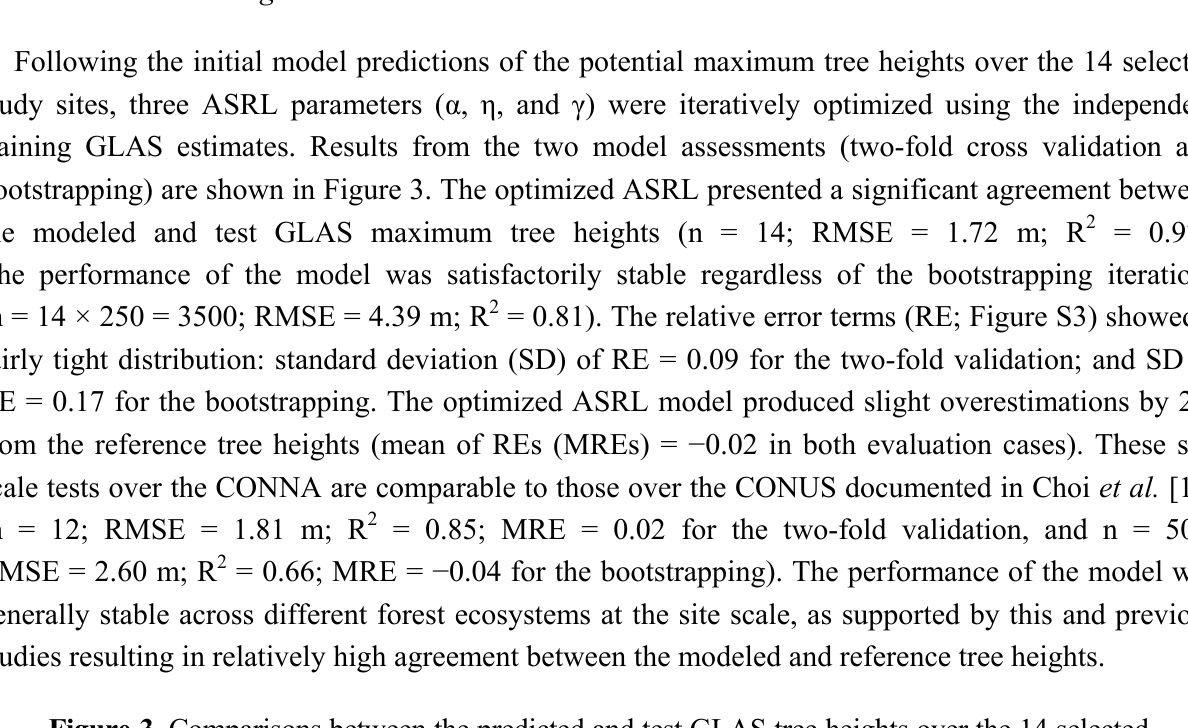
Figure 3. Comparisons between the predicted and test GLAS tree heights over the 14 selected study sites: ( a ) Two-fold cross validation and ( b ) bootstrapping